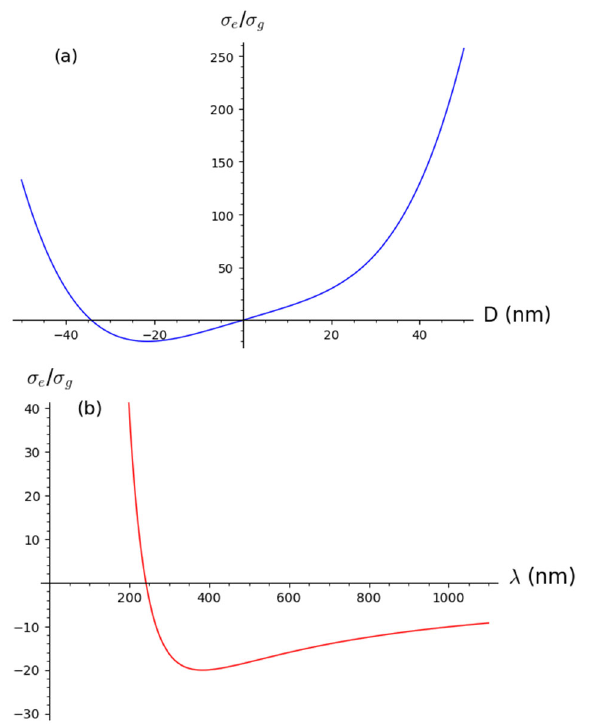
Figure 2. Dependence of extinction to geometric cross section ratio on diameter of nanoparticles ( a ) and on wavelength ( b ).